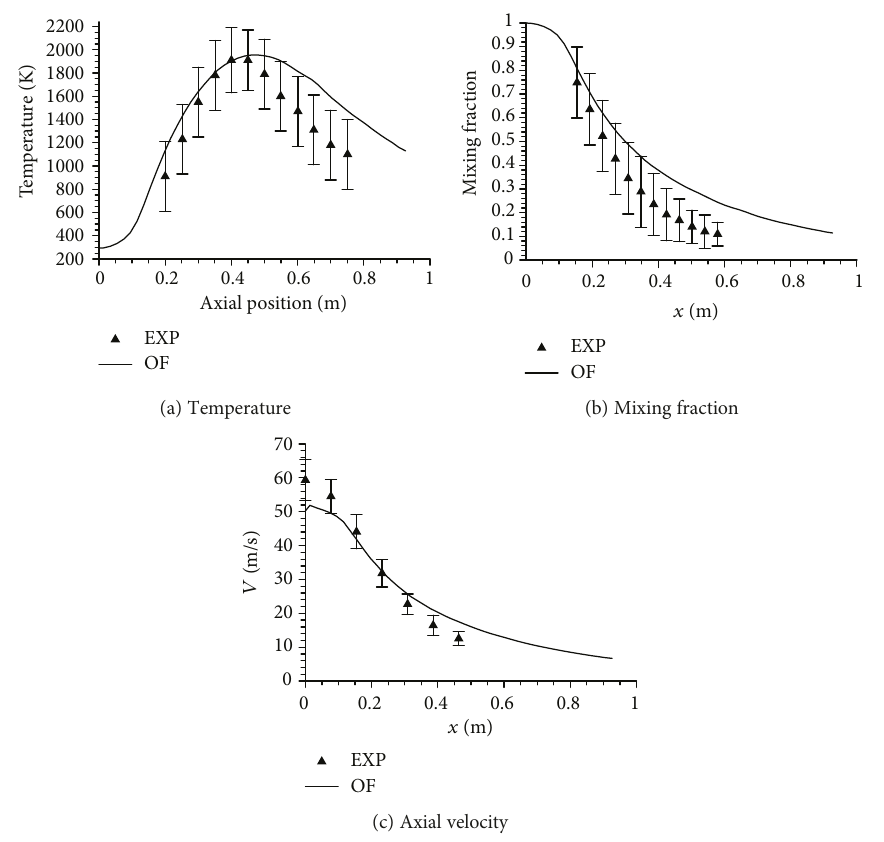
Figure 3: Pro fi le comparison at the centerline of fl ame